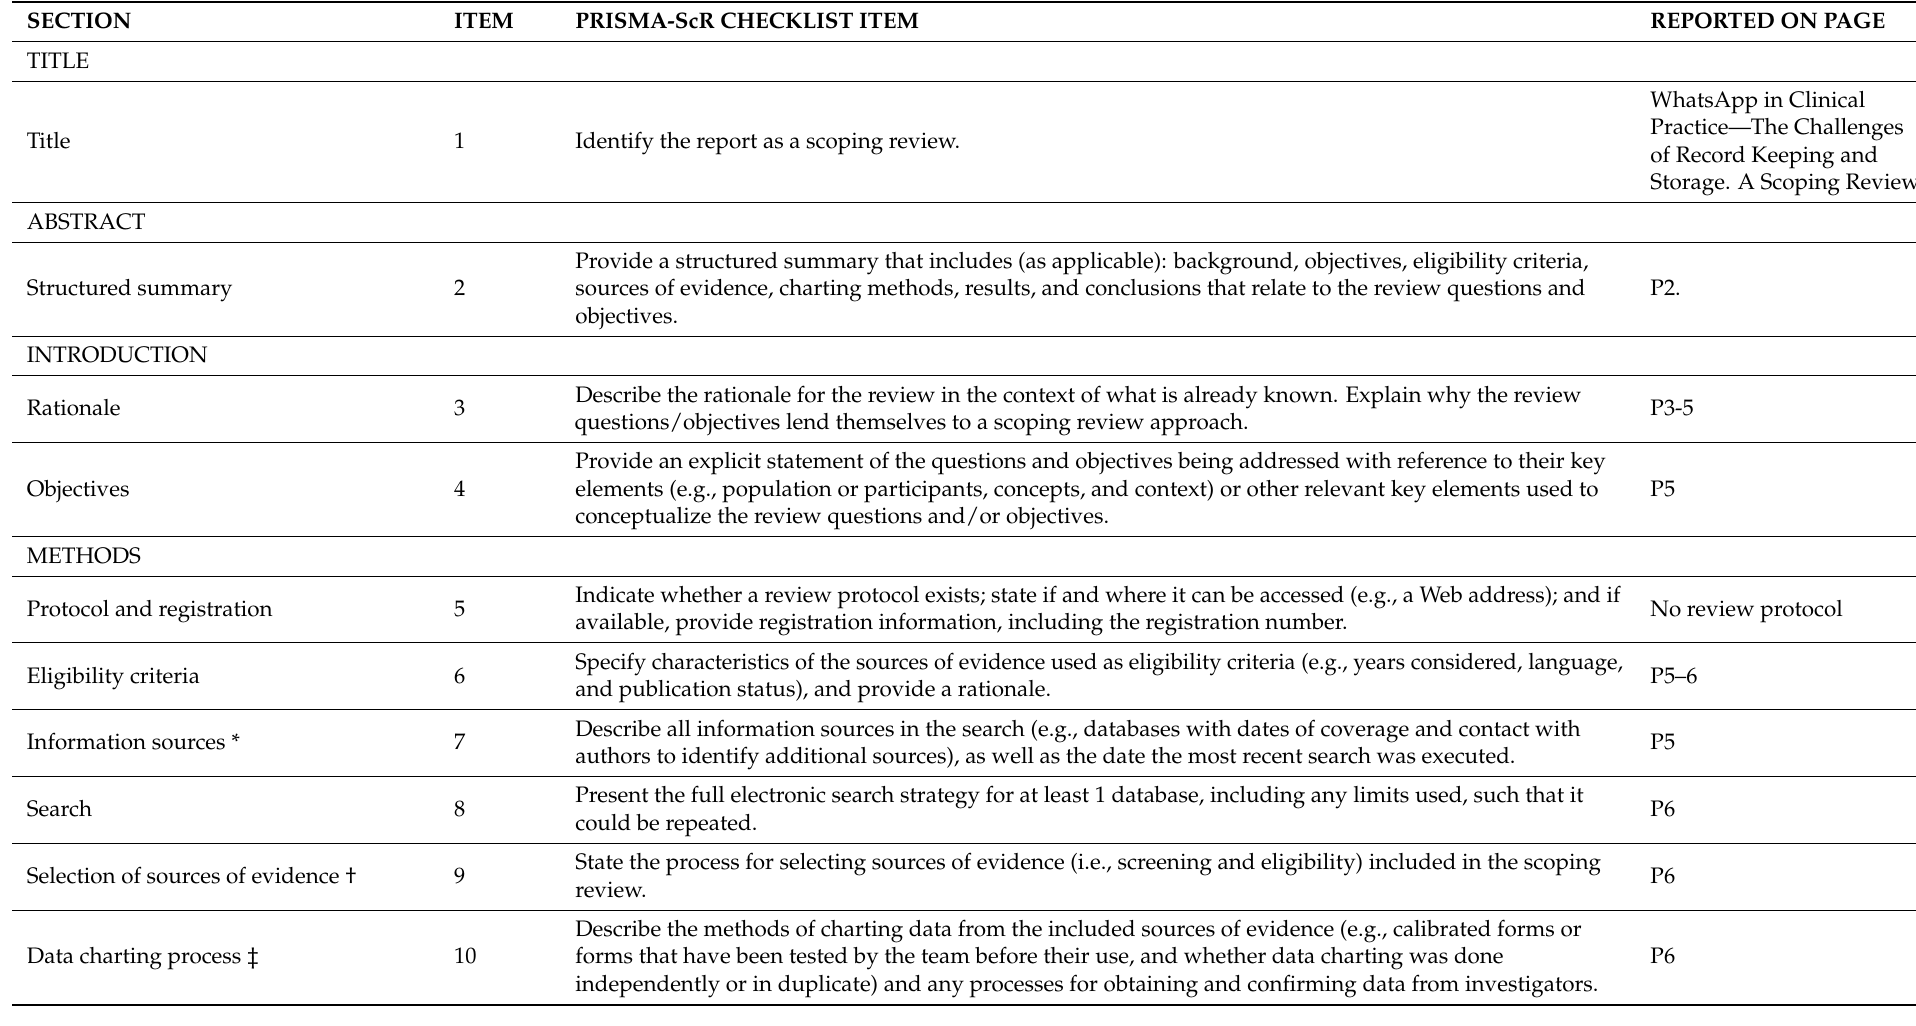
Table A2. Preferred Reporting Items for Systematic reviews and Meta-Analyses extension for Scoping Reviews (PRISMA-ScR)